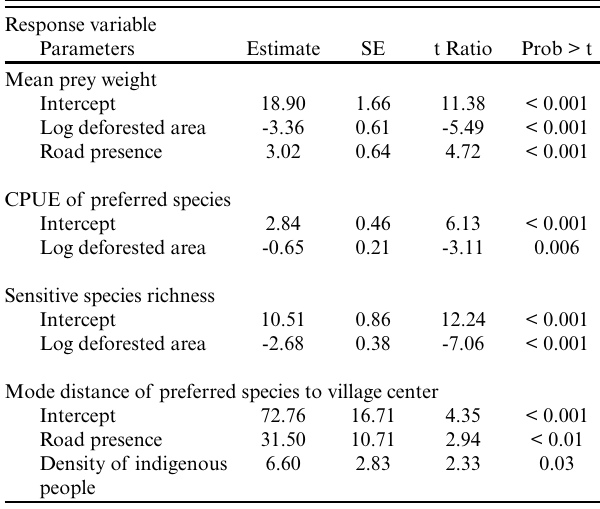
Table 4 . Explanatory variables included in the final regression models after stepwise and supervised